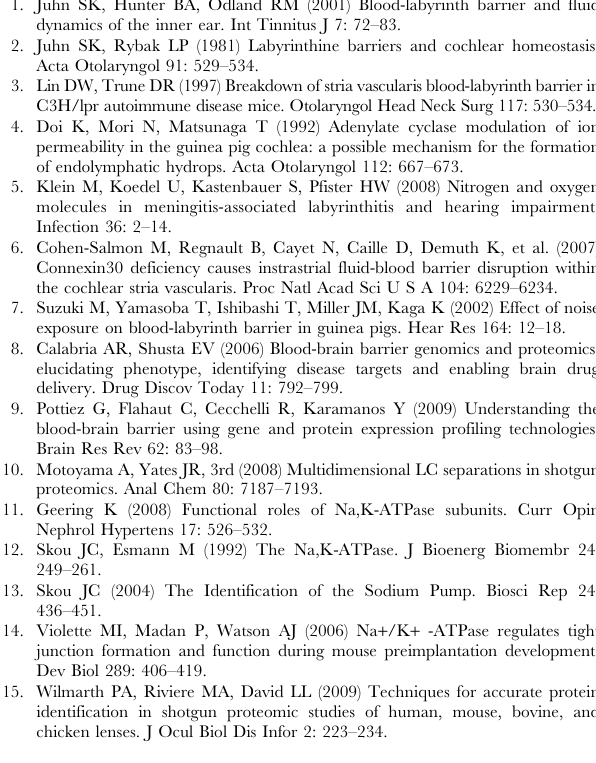
Figure S4 ABR hearing thresholds were measured from the noise-exposed and control mice (n = 10) at 4, 8, 12, 16, 24 and 32 kHz. *Significantly different from control mice (***P , 0.001). Error bars represent SEM. (TIF) Figure S5 The expression of ATP1A1 in response to noise exposure. A , Real-time PCR showed the expression of mRNAs of Na + , ATP1A1, ATP1B1 and ATP1B2 in the control and noise-exposed (NE) animals. ATP1A1 mRNA was highly up-regulated in response to noise exposure. (** P = 0.0043 , 0.01, n = 3). However, ATP1B1 and ATP1B2 mRNA did not reveal a significant difference in NE animals. B and C , Immunoblots quantified by densitometry shows that expression of ATP1A1 was significantly increased in the NE animals. (* P = 0.032 , 0.05, n = 5). (TIF) Dataset S1 Summary of the 652 proteins identified in stria vascularis capillaries. Common contaminant, se- quence-reversed decoys, and proteins with insufficient unique peptide evidence are not listed. (XLS) Dataset S2 Functional classification and annotation of proteins identified in this stria vascularis capillaries proteomic